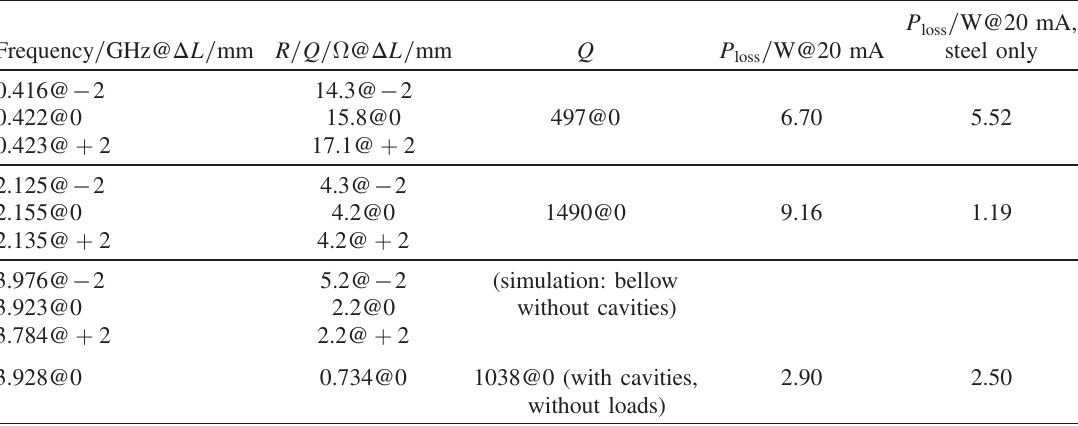
TABLE I. HOM power of the lowest three modes in the CSB.